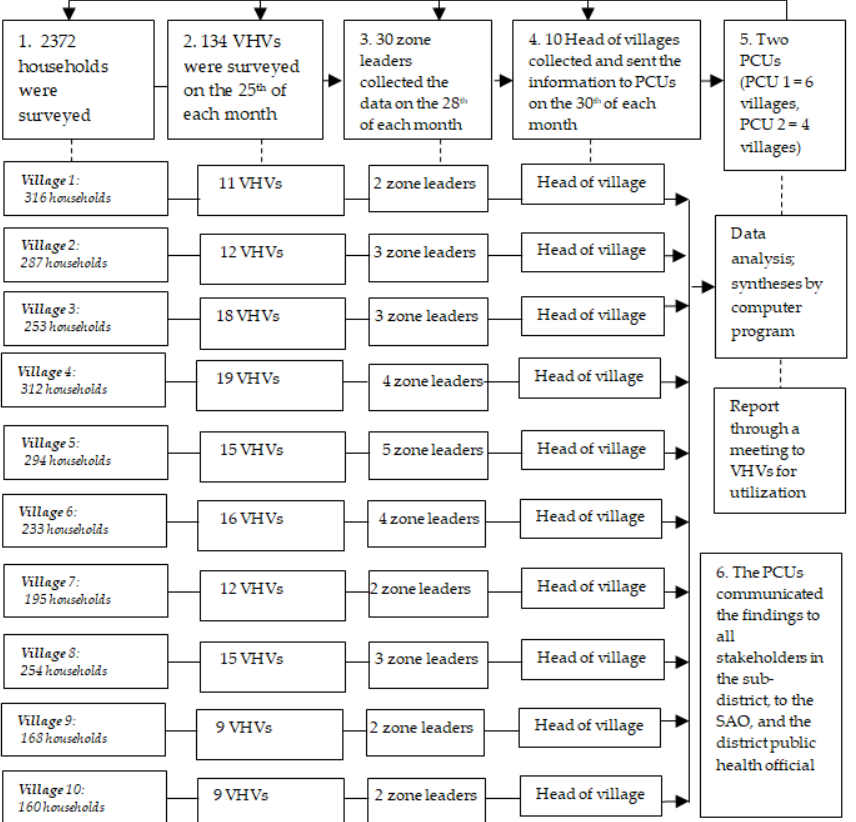
Figure 1. Larval indices surveillance system in 10 villages of the subdistrict. SAO = subdistrict administration; VHV = village health volunteer; PCU = primary care unit.